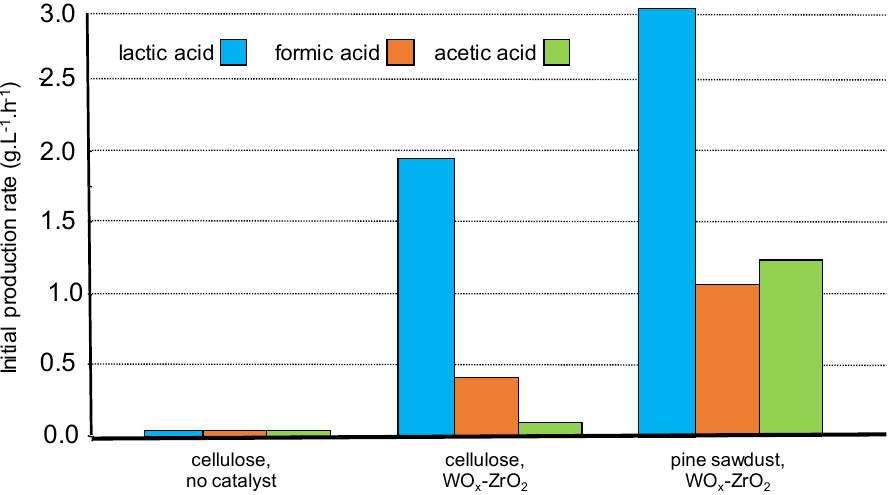
Figure 7. Comparison of cellulose and lignocellulose transformation in the presence of WO x -ZrO 2 (water 65 g, wood 0.68 g, catalyst 0.3 g, 190 °C). Adapted from [63].